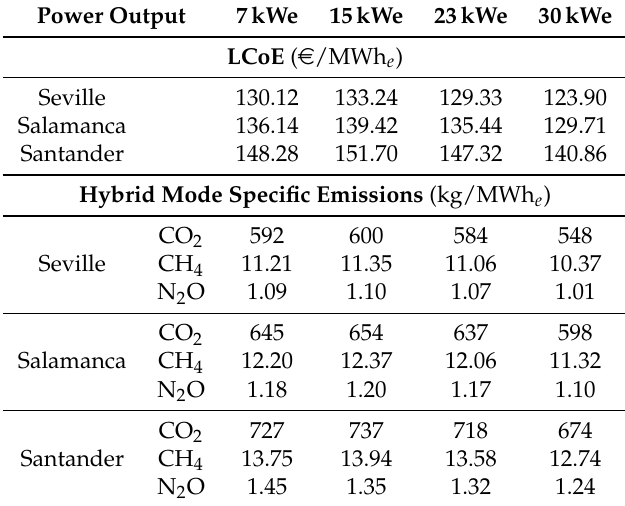
Table 4. Summary of the LCoE and specific emissions for different power outputs and